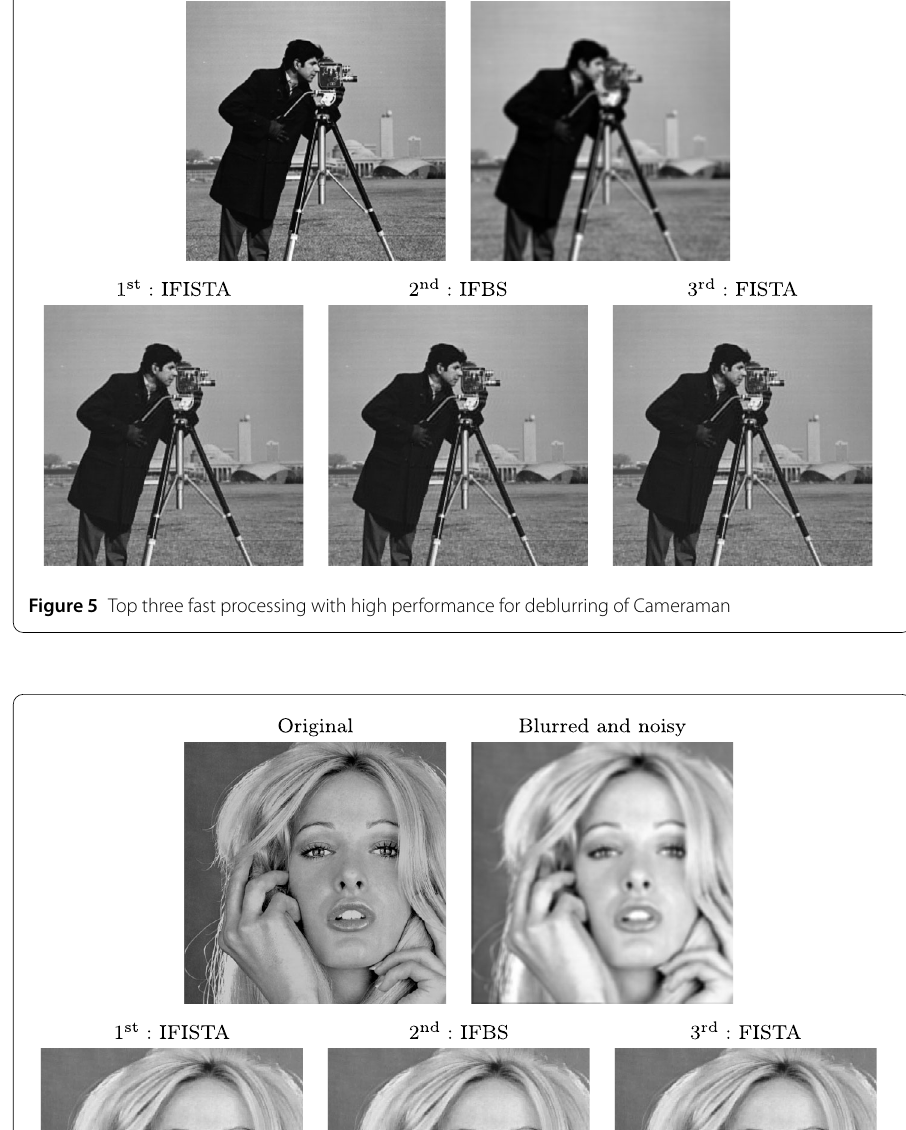
are satisfied, where SNR and ISNR of NAGA are greater than both IFBS and IFISTA, and also which of IFBS are greater than IFISTA, and then, we conclude that NAGA, IFBS, and IFISTA are in the 1 st , 2 nd , and 3 rd place, respectively, of the top three fast convergence with good performance for compared image deblurring as Fig. 9, Fig. 10, Fig. 11, and Fig.